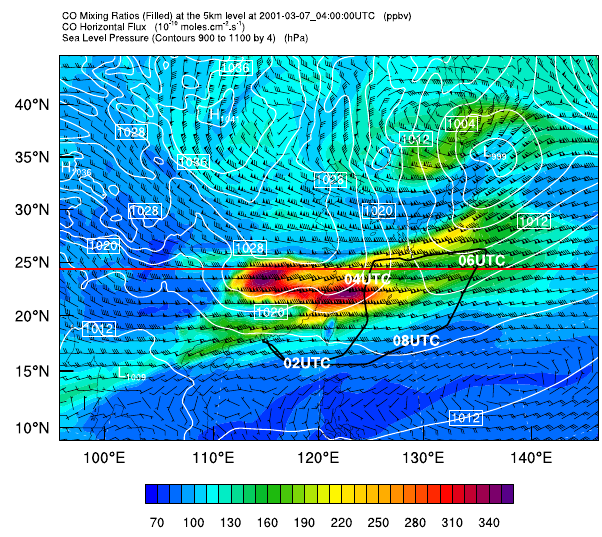
Figure 4. WRF-Chem simulated CO mixing ratios (filled) and horizontal fluxes (bars) at the 5-km level superimposedwith sea level pressure(contours) at 04:00 UTC on 7 March. Thered horizontal lineapproximatesthefrontalsystemconvergenceband,alongwhichaverticalcross-sectionisshown in Figure 5. The thick black line labeled with UTC denotes the flight track of the NASA DC8 for which the chemical distributions are illustrated in Figure 6.